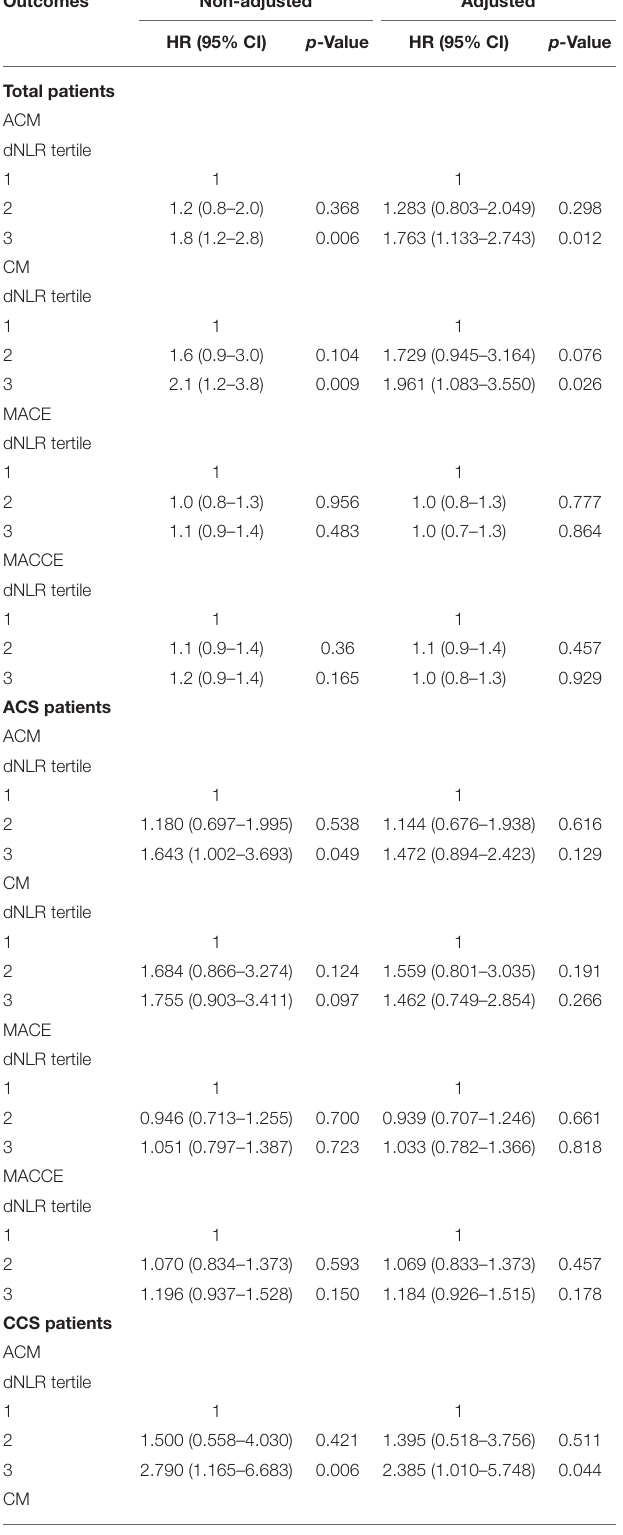
TABLE 3 | Univariate and multivariable Cox regression analysis for outcomes.